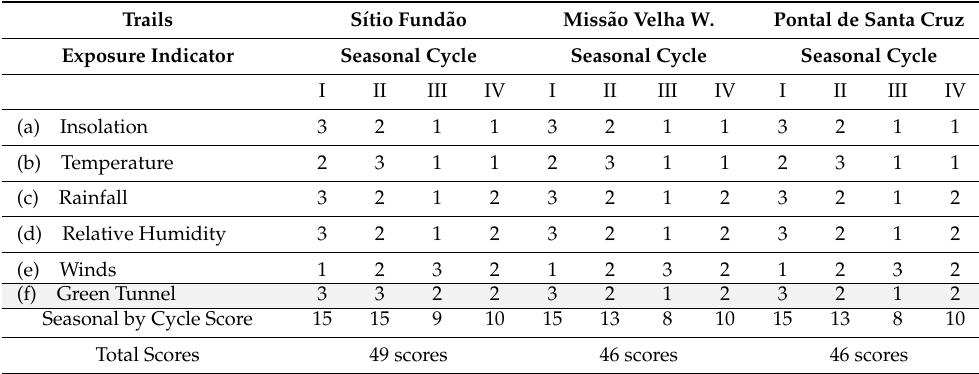
Table 2. Classification of Weather and Climate Exposure in the Araripe Trails UGG.